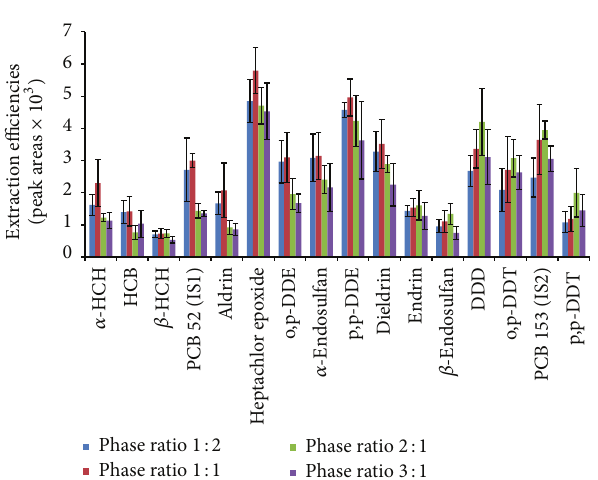
Figure 4: Effect of phase ratio on the extraction efficiencies of analytes.